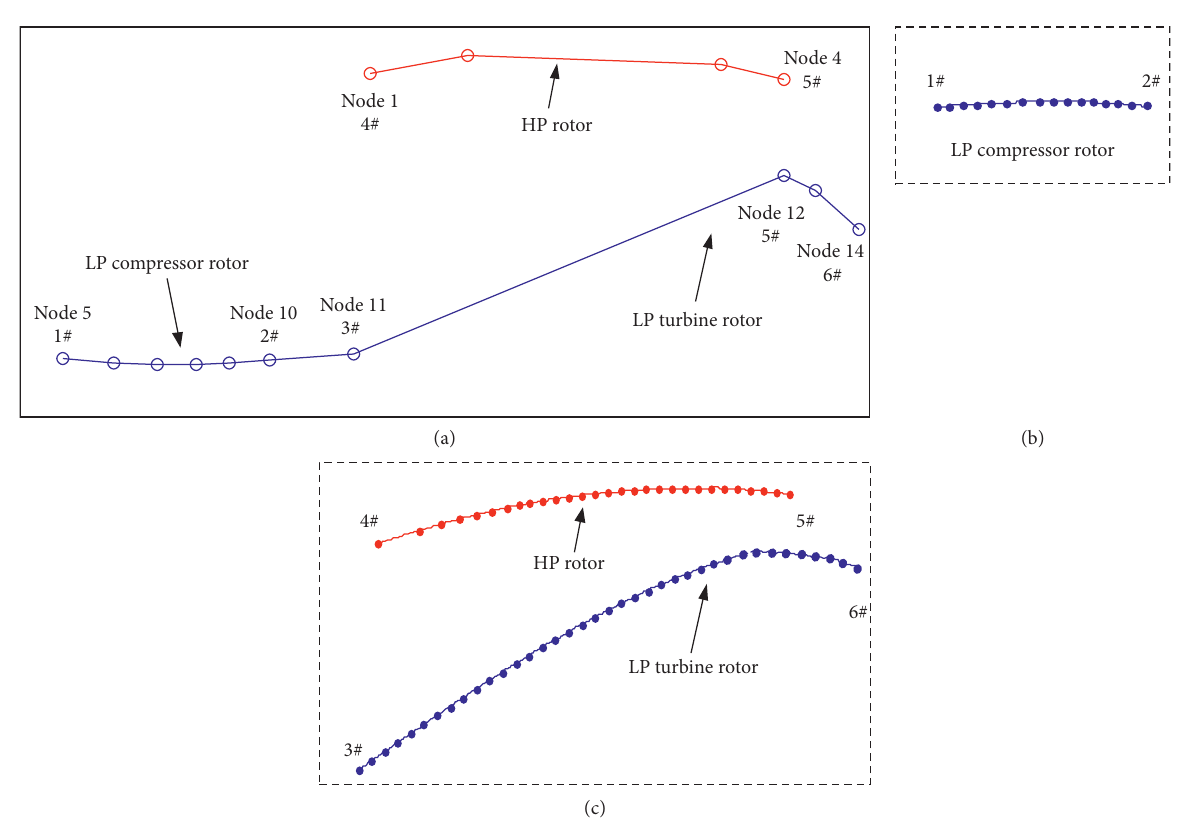
Figure 13: Modal shapes (a)fororiginal dynamicalmodelin Figure3at thefirstcritical speed ω , and (c) for separated dual-rotor system in Figure 11 at ω B at ω B 1